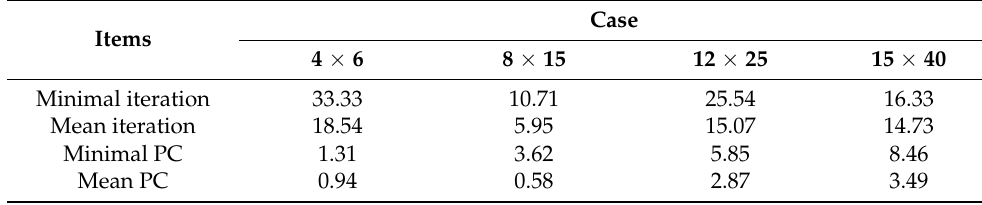
Table 9. rpd s (%) of the convergence